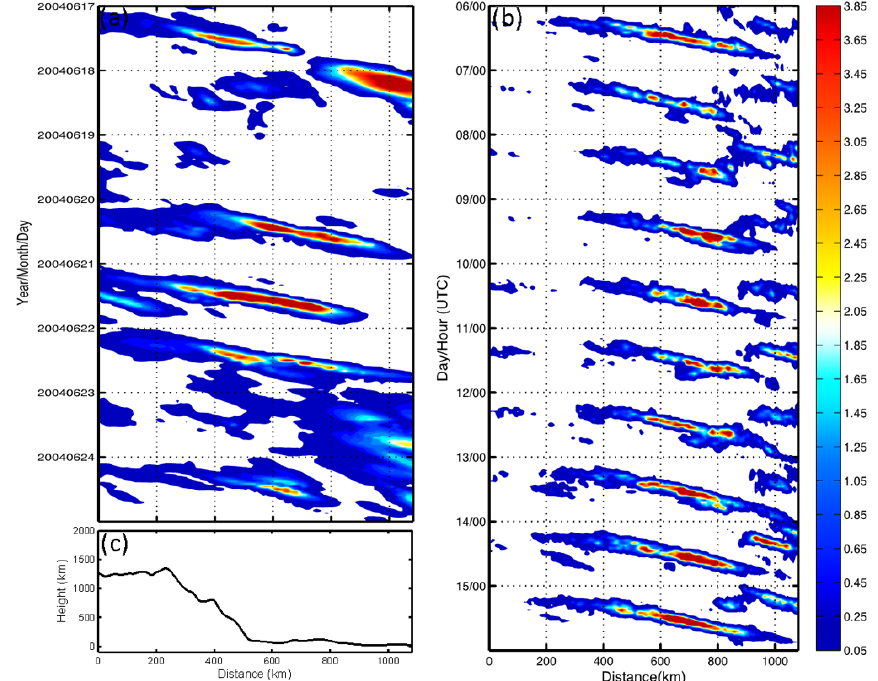
Fig. 3. Hovm¨oller diagram of the rain rate (mmh − 1 ) averaged along the northwest–southeast cross section over ABEF for (a) 17– 24 June 2004 from CMORPH and (b) the final 10 days of the control simulation (CNTL). (c) Averaged terrain elevation along the northwest– southeast direction over